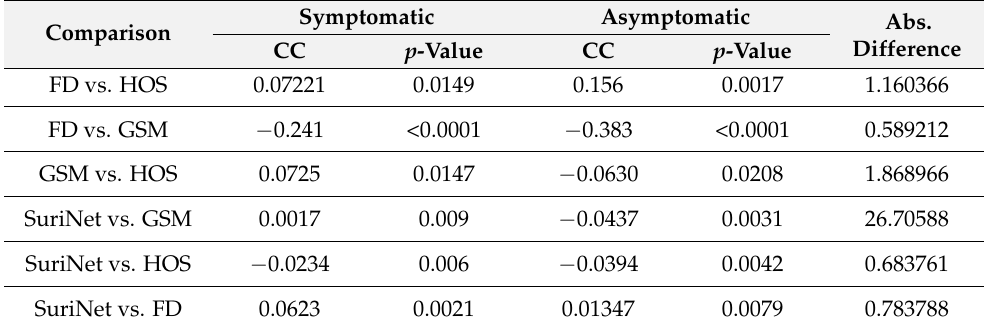
Table 5. Correlation